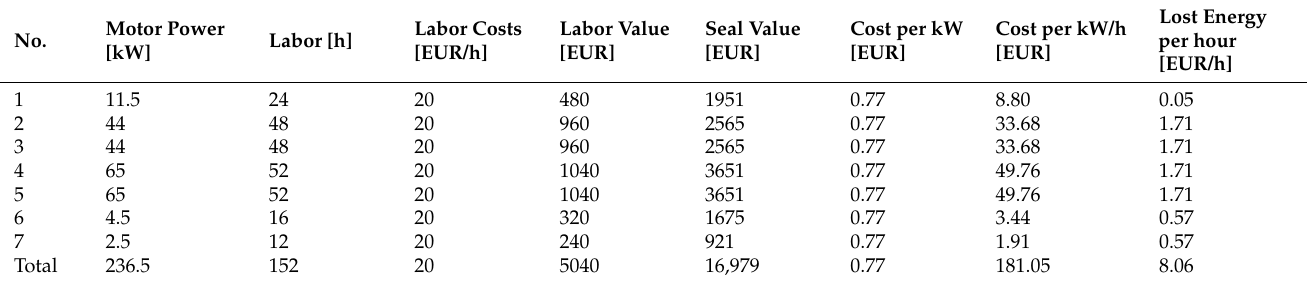
Table 1. Maintenance costs